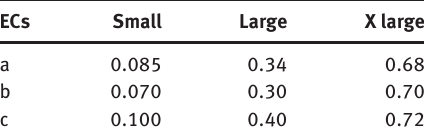
Table 9: EC Price.